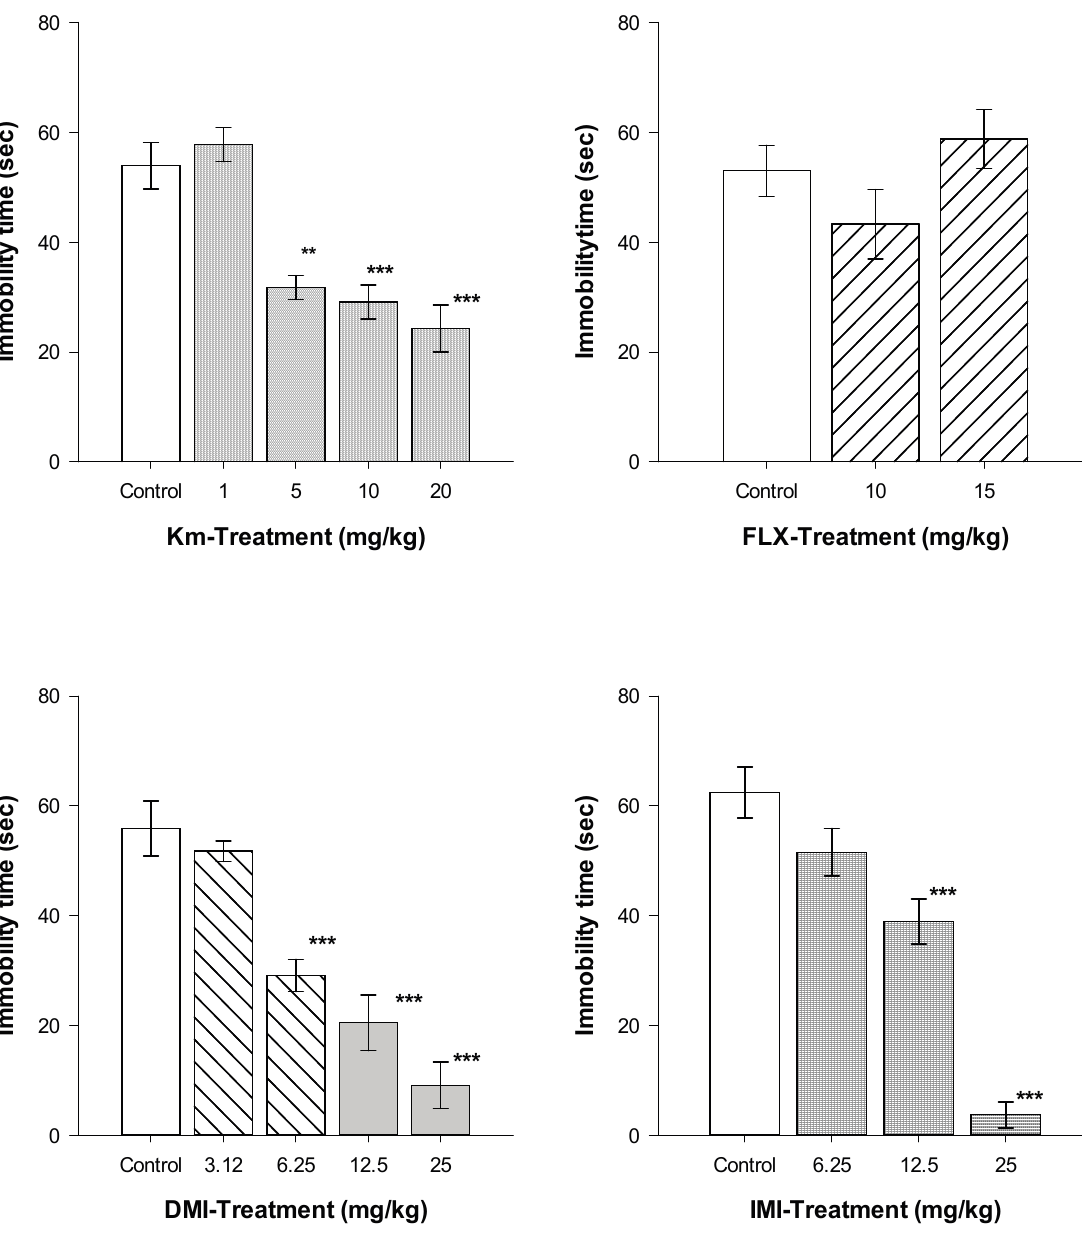
Figure 3. Antidepressant-like effects Km, FLX, DMI, and IMI on the Forced Swimming